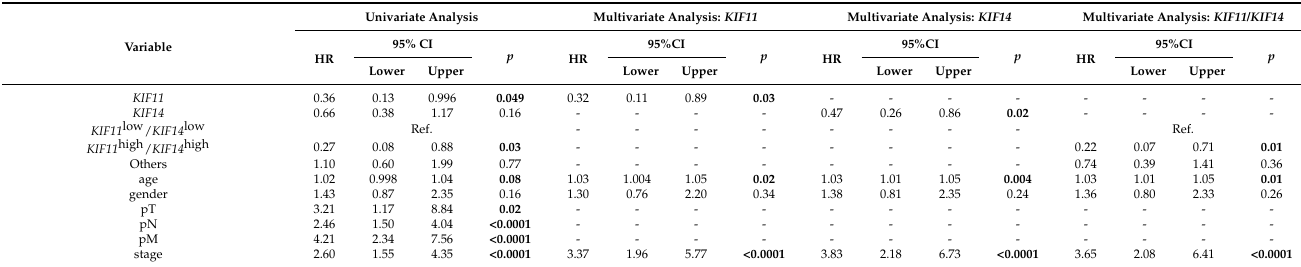
Table 4. Univariate and multivariate Cox proportional hazards models for OS of TCGA cohort of CRC patients. UnivariateAnalysis MultivariateAnalysis: KIF11 MultivariateAnalysis: Variable